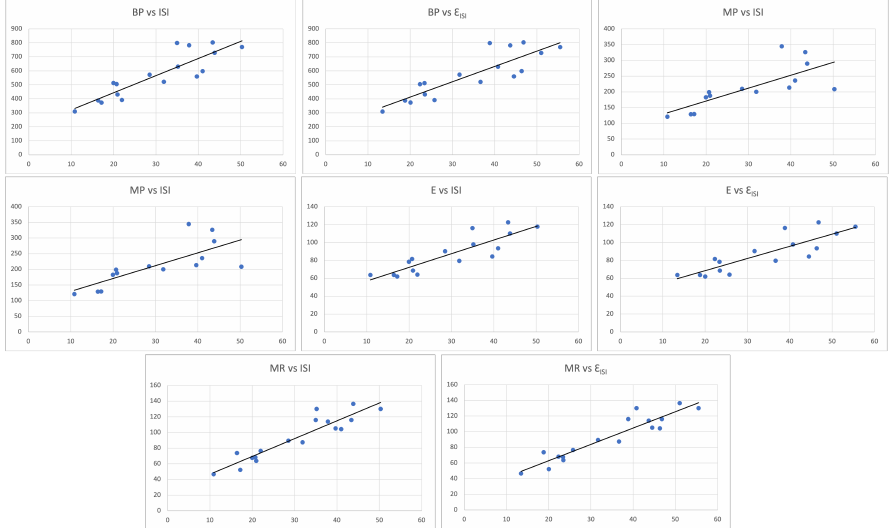
Figure 2. Linear Regression for Physical Property with the ISI -index and E ISI of Anticancer